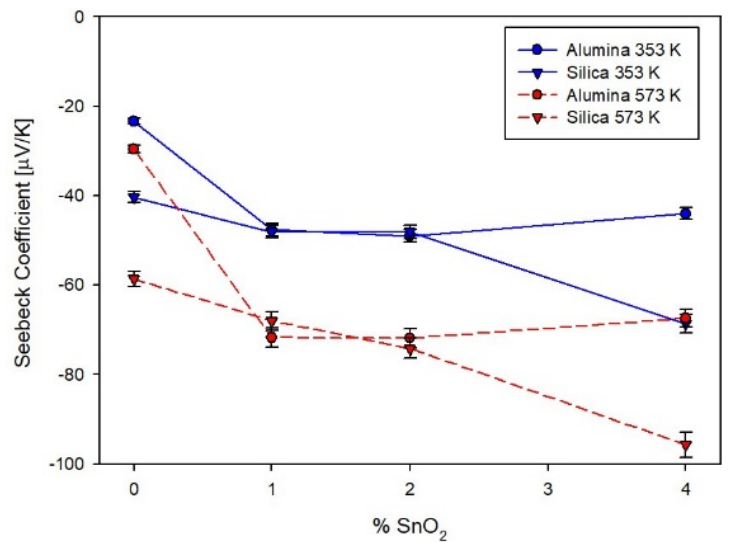
The Seebeck coefficient S is plotted versus the concentration x of SnO 2 in Figure B2. The undoped sample had the lowest S while the sample with x = 4 had the largest S .